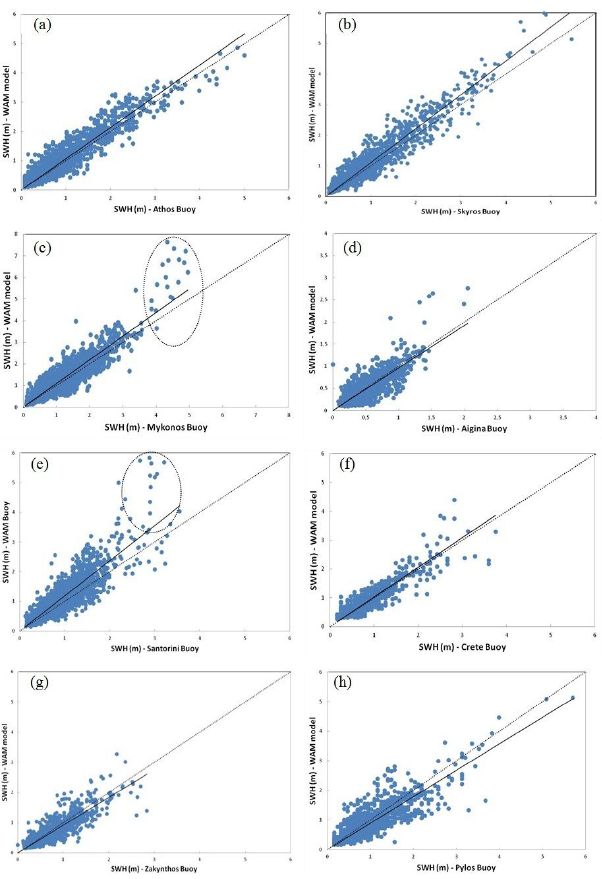
Fig. 2. Scatter plots of significant wave height, measurements ver- sus WAM model at (a) Athos, (b) Skyros, (c) Mykonos, (d) Aegina, (e) Santorini, (f) Crete, (g) Zakynthos and (h) Pylos. The